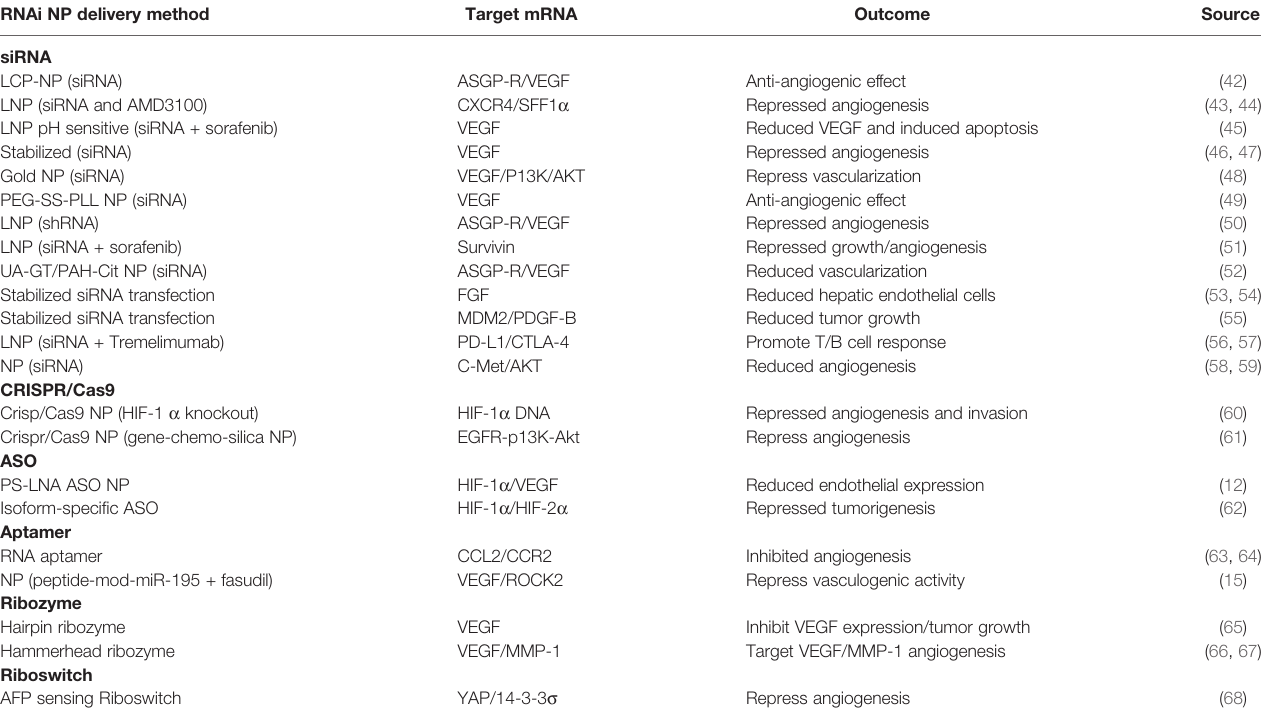
TABLE 1 | RNAi anti-angiogenesis therapeutics. RNAi NP delivery method Target